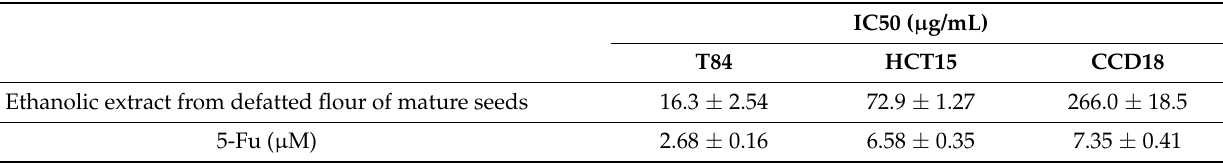
3.3. Effect of the Ethanolic Extract of Euphorbia Lathyris on Cell Viability The ethanolic extract from the defatted flour of Euphorbia lathyris was assayed in colon cancer cells with different degrees of chemo-resistance to determine its antitumor activity. As shown in Table 4, the extract showed a lower IC50 in the T-84 cancer cell line (16.3 ± 2.54 µ g/mL) compared to the chemo-resistant colon cancer cell line HCT-15 (IC50 of 72.9 ± 1.27 µ g/mL). In contrast, its antiproliferative effect on the normal colon cell line CCD18 was low (266.0 ± 18.5 µ g/mL) compared to tumor cells. As positive control, 5-fluoroacile (5-Fu) was tested. Based on these results, the ethanolic extract was assayed in glioblastoma multiforme, pancreatic adenocarcinoma, and breast cancer cell lines. As shown in Table 5, the ethanolic extract from the defatted flour of Euphorbia lathyris exhibited antitumor activity in the glioblastoma multiforme cell line, with a lower IC50 in A-172 cells (18.6 ± 1.64 µ g/mL) compared to the other cell lines (LN-229, SF-268, and SK-N-SK). With regard to pancreatic adenocarcinoma and breast cancer cell lines, IC50 values were higher than in the other tumor cell lines (185.8 ± 25.8 µ g/mL and 89.6 ± 6.29 µ g/mL, respectively). Table 4. Cytotoxicity activity (IC50) of the ethanolic extracts from the defatted flour of Euphorbia lathyris in colon cancer and non-tumor colon cell